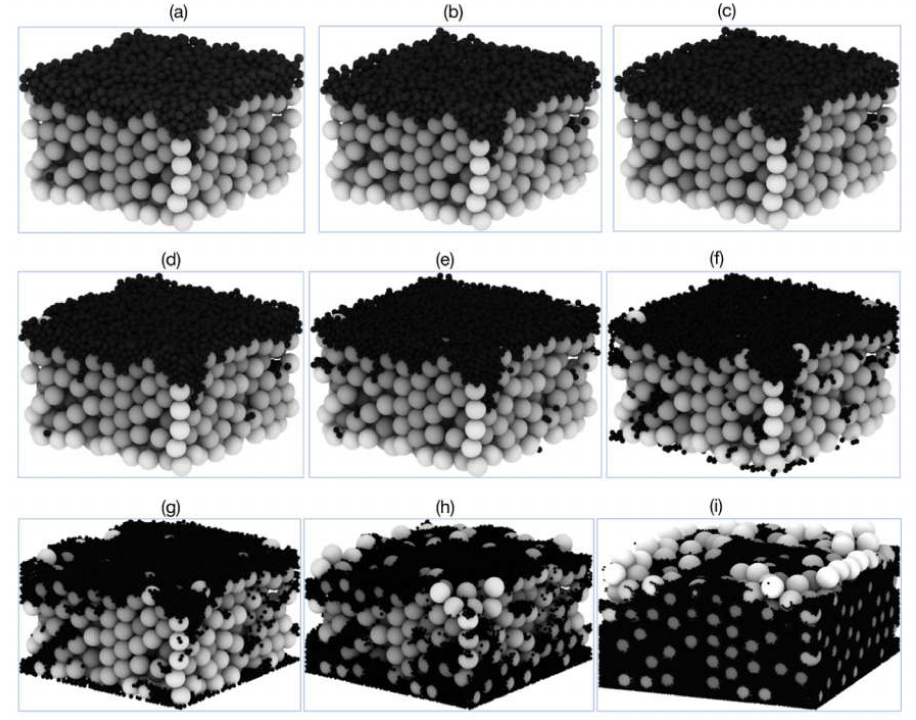
Figure 5. Fine sediment distribution dependent on the size ratios ( a ) d / D = 0.45; ( b ) d / D = 0.414; ( c ) d / D = 0.40; ( d ) d / D = 0.35; ( e ) d / D = 0.30; ( f ) d / D = 0.25; ( g ) d / D = 0.20; ( h ) d / D = 0.154; ( i ) d / D =